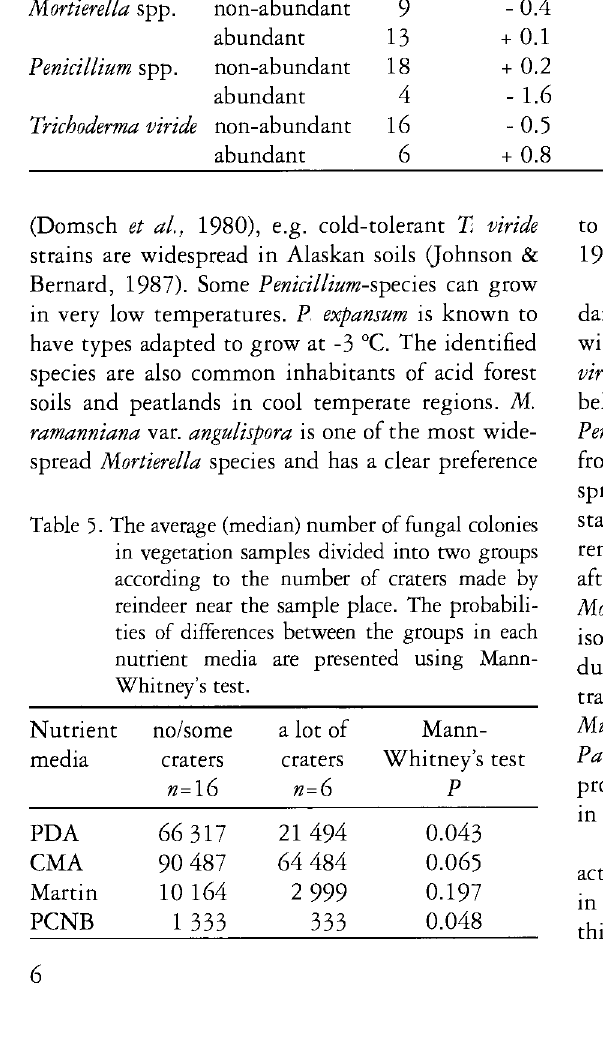
Table 4. The average (mean) temperature (°C) on the soil surface under the snow lay er and the average (median) snow depth (cm i) in the sample places divided into two groups according to fungal abundance. The probabilities of differences between the groups are presented using Mann-Whitney's